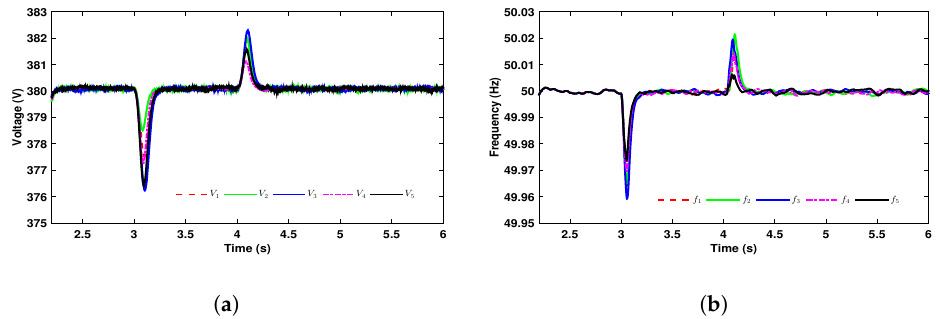
Figure 8. Restoration with communication topology change. ( a ) Voltage. ( b )